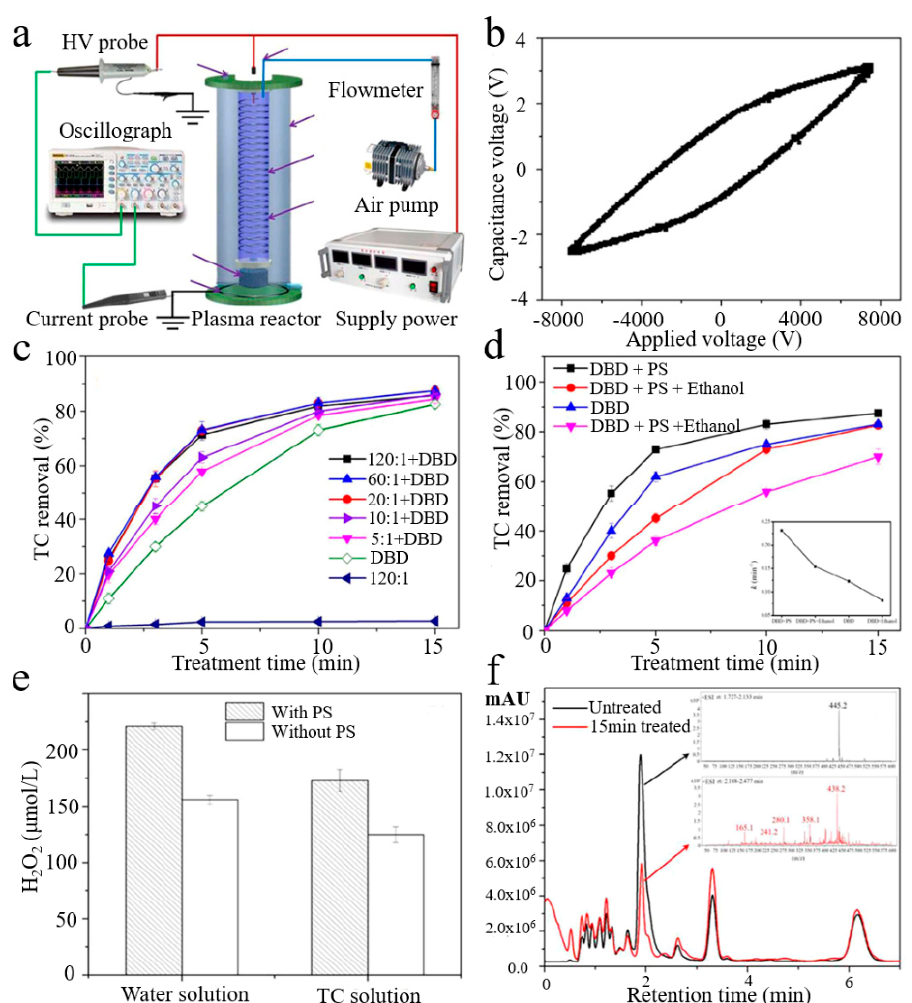
Figure 14. ( a ) gas phase surface discharge device diagram; ( b ) Lissajous figure; ( c ) effect of PS addition ratio on the TC removal; ( d ) effect of ethanol on TC removal; ( e ) effect of ethanol on H 2 O 2 production; ( f ) total ion chromatograph and HPLC/MS chromatograph of TC decomposition intermediates. Reproduced with permission from [153]. Copyright Elsevier, 2018.